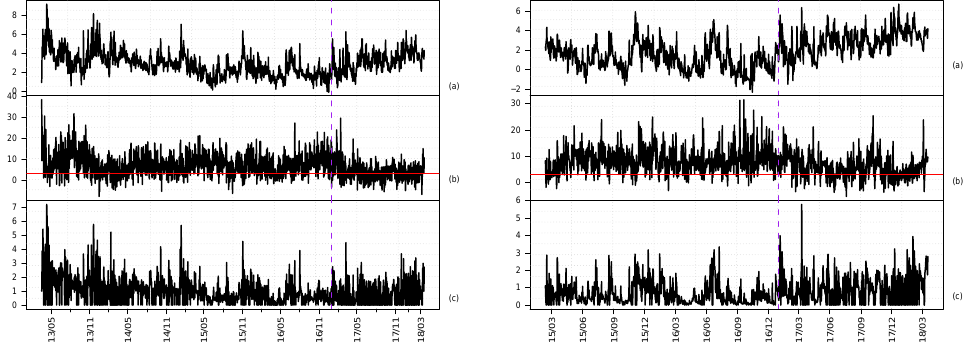
Figure 6. Plot of logarithmic realized variance log ( RV t ) ( a ), Z t ( b ) and logarithmic significant jumps log ( J t + 1 ) ( c ) over time. Purple vertical dashed lines indicate the start of the Hype period. The horizontal red line indicates the 1 − τ quantile of a standard Gaussian distribution for τ = 0.01. Figures on the left panel are for Bitstamp, figures on the right panel for Coinbase.